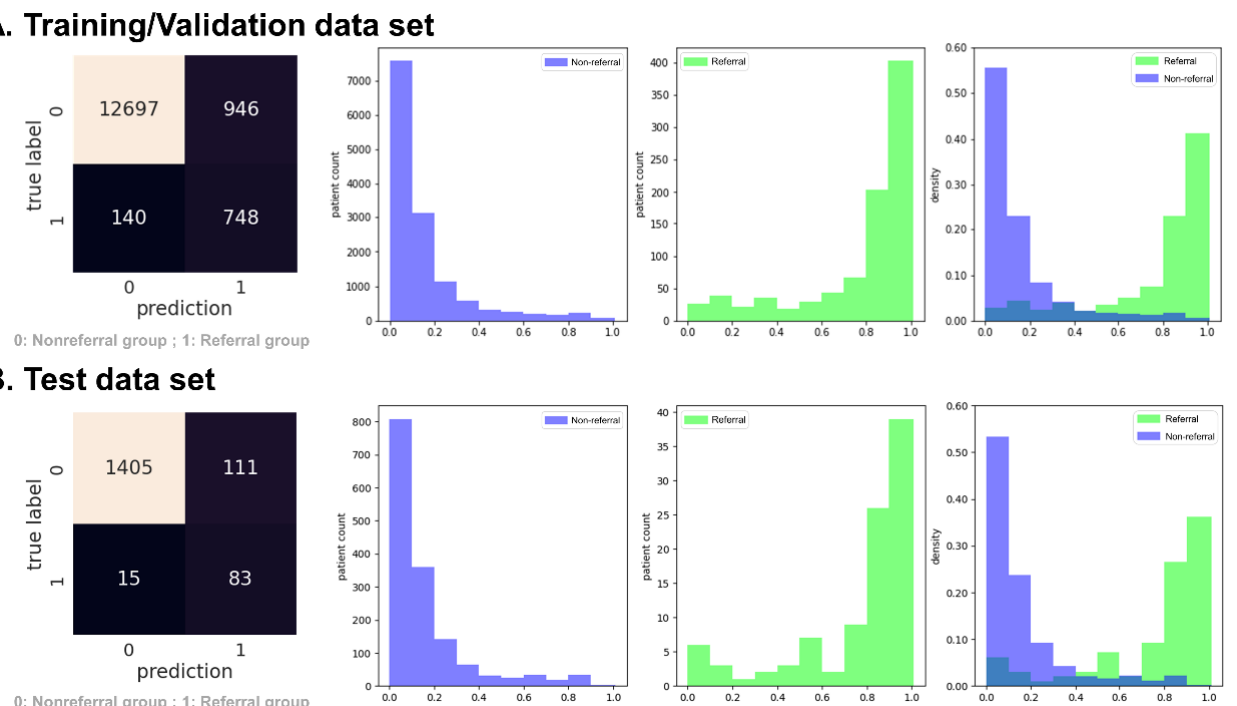
Figure 5. Confusion matrix and predictive probabilities histogram of the XGBoost model in experiment 2 (persistent eGFR < 45 mL/min/1.73 m 2 ). The green in the histogram represents the referral group, and the medium slate blue represents the non-referral group.